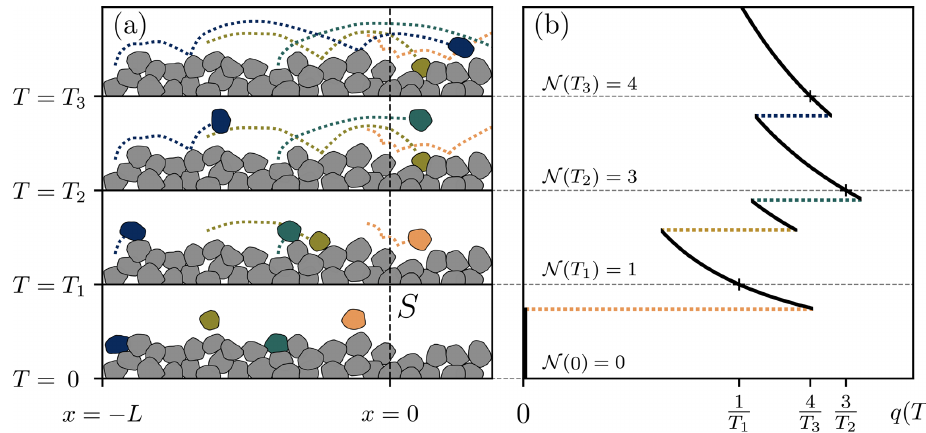
Figure 2. Panel (a) indicates the configuration for the flux. Here, time increases from the bottom to the top. Particles begin their transport with positions − L ≤ x ≤ 0 to the left of S at observation time T = 0, and the flux is calculated in panel (b) as the rate N ( T ) /T of particles crossing x = 0 over the observation time T . Particle crossing events are indicated in (b) by color-coded lines. The probability distribution of q ( T ) is determined from all possible realizations of the trajectories and initial positions as N and L tend to infinity, while the density of particles ρ = N/L to the left of S is held